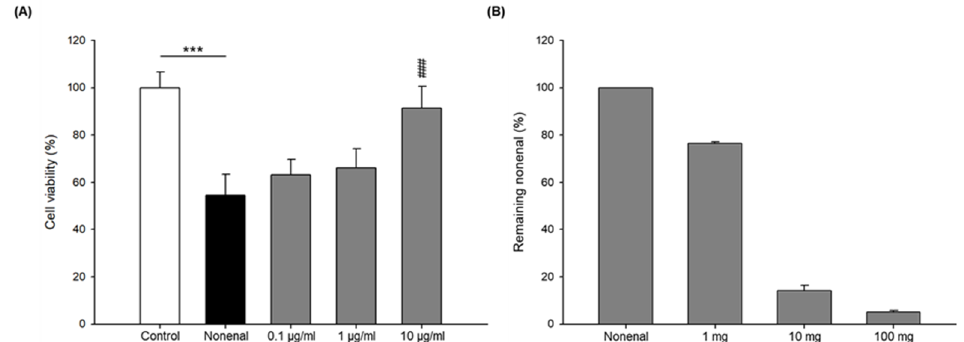
Figure 1. Effects of LRC extract with trans -2-nonenal on the cell viability of human keratinocytes and the quantitative reduction of trans -2-nonenal by LRC extract. These data are expressed as mean ± SD of three independent experiments. ( A ) Cell viability of human keratinocytes treated with trans -2-nonenal (150 μM) and LRC extract (0.1, 1, 10 μg/mL). *** p < 0.0001 vs. control; ### p < 0.0001 vs. trans -2-nonenal. ( B ) The LRC extract at different concentrations (1–100 mg/mL) and trans-2-nonenal (0.1 mM) were incubated in PBS (100 mM, pH 7.4) at 37.5 °C for 24 h.